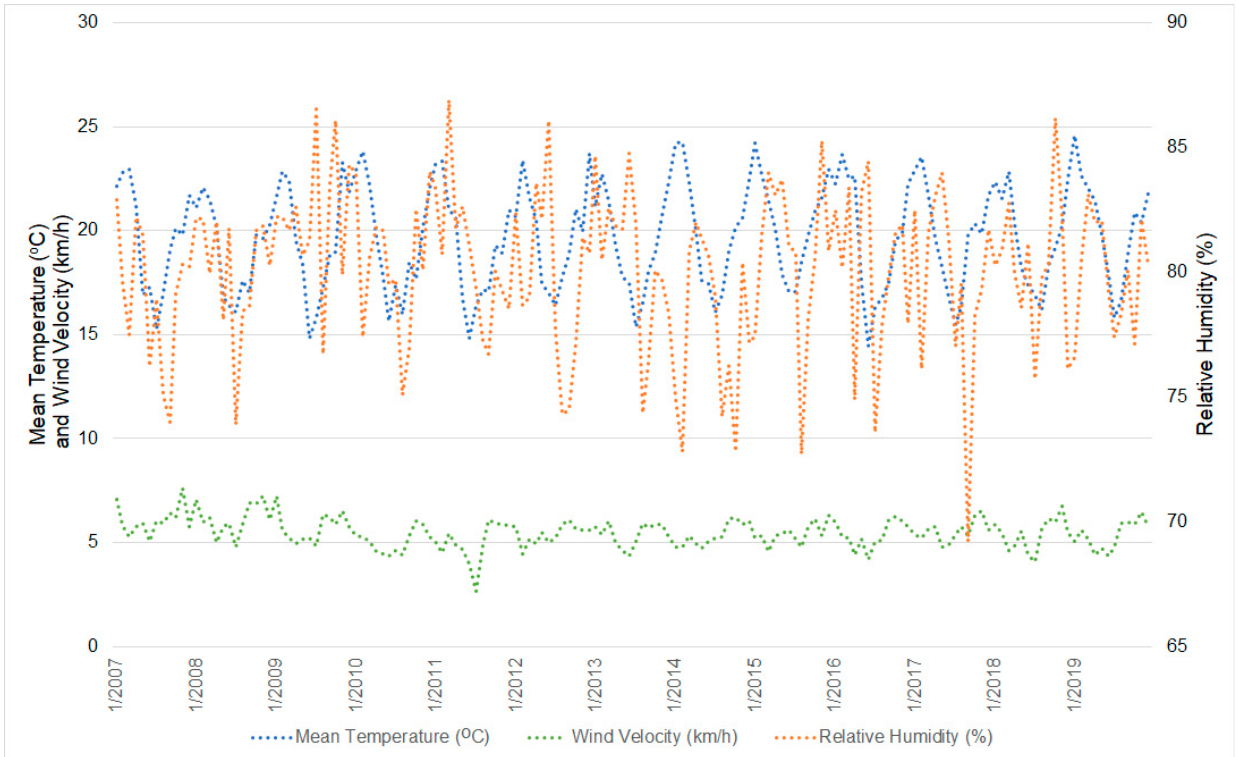
Figure 4. Line graph showing the daily variation of the mean temperature, wind velocity, and relative humidity variables between 2007 and 2019.